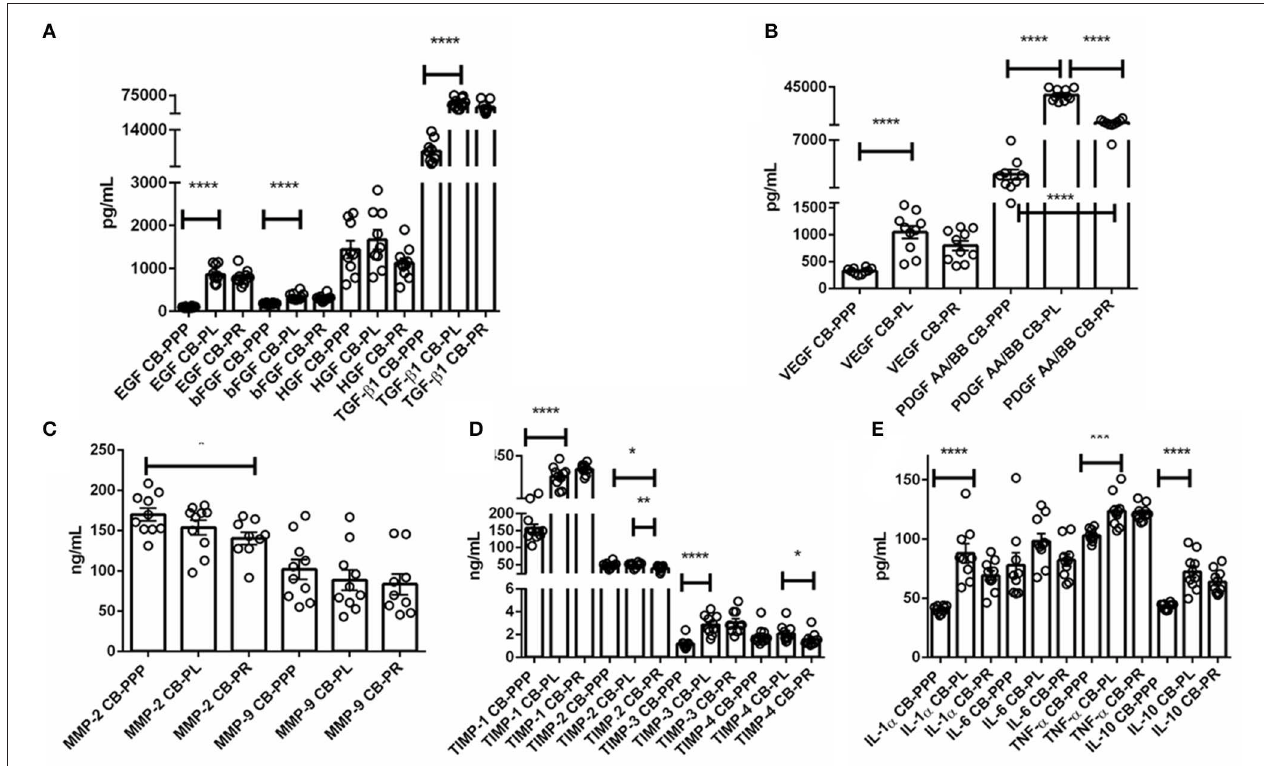
FIGURE 2 | (A) Trophic and wound healing factors in CB-PRP preparations in pg/mL, growth factors analyzed were EGF, bFGF, HGF, and TGF- β 1. (B–D) Concentration of the angiogeneic group of factors in CB-PRP derived preparations. Results show concentration in pg/mL and ng/mL of each factor. The analytes measured were (B) VEGF and PDGF in pg/mL; (C) MMP-2 and MMP-9 in ng/mL; (D) TIMP1-4 in ng/mL. (E) Concentration of inflammatory and anti-inflammatory cytokine group of analytes in CB-PRP preparations. Data points represent concentration mean of IL-1 α , IL-6, and TNF- α pro-inflammatory and IL-10 anti-inflammatory cytokines. CB-PRP preparations investigated were, cord blood platelet poor plasma (CB-PPP; n = 10), cord blood platelet lysate (CB-PL; n = 10) or cord blood platelet releasate (CB-PR; n = 10). Each sample was measured in duplicate in two separate experiments. Data points represent concentration mean.